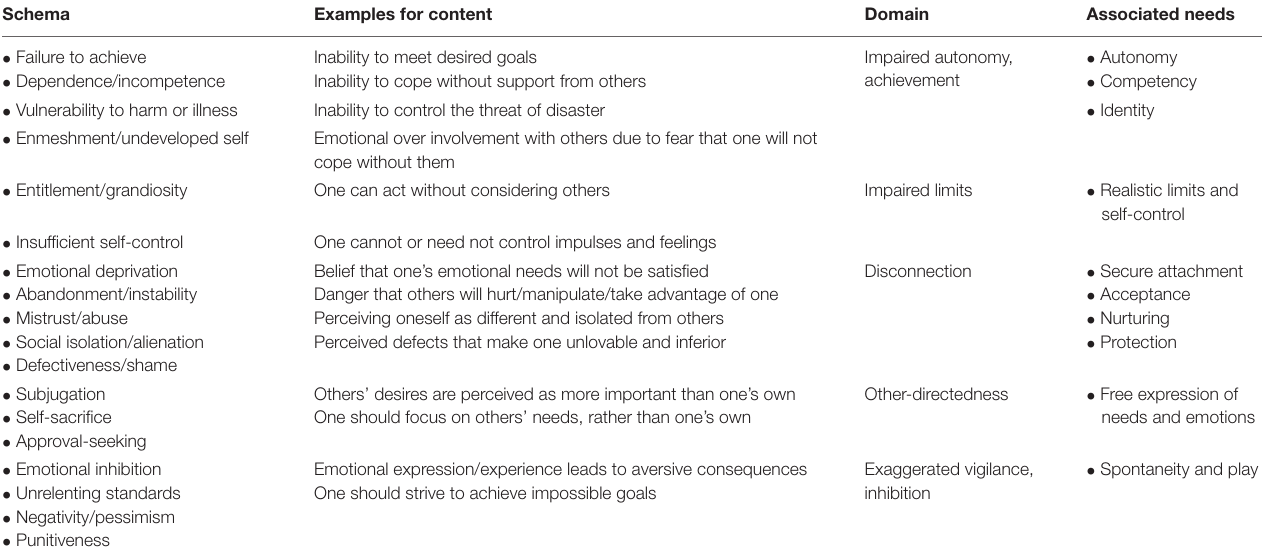
TABLE 1 | Overview of schemas subsumed in schema domains and associated needs according to Young (1994, 1999).